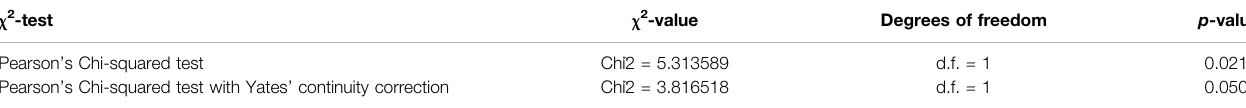
TABLE 4 | Statistics between the eighth and ninth graders ’ reports on the problem-solution “ we asked for help from the other students. ”